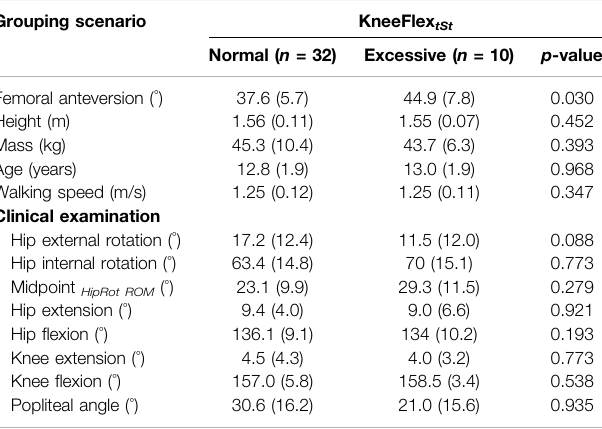
TABLE 2 | Anthropometrics and clinical examination for sub-grouping scenario based on knee fl exion in terminal stance. Values are presented as means (standard